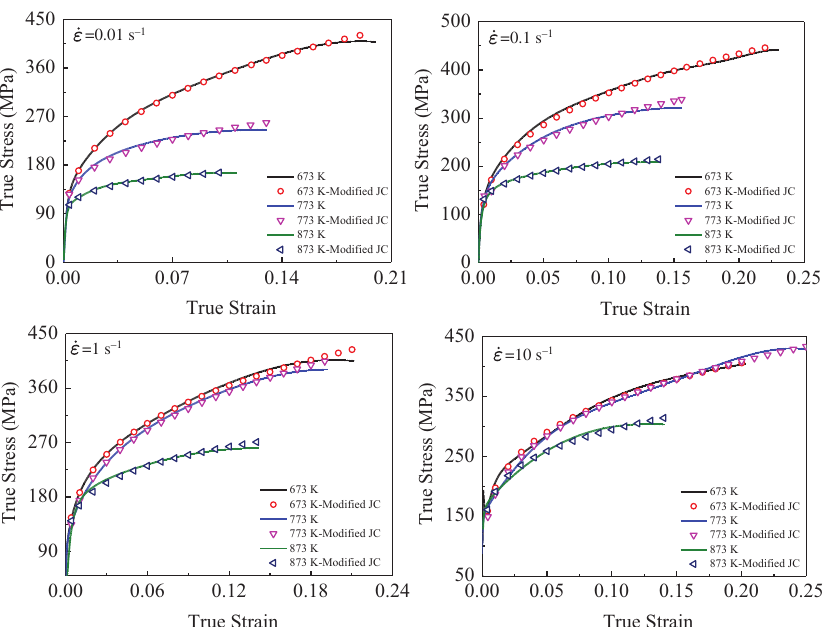
Figure 13: Comparisons between predicted and measured of BR1500HS alloy under medium deformation temperatures with strain rates of